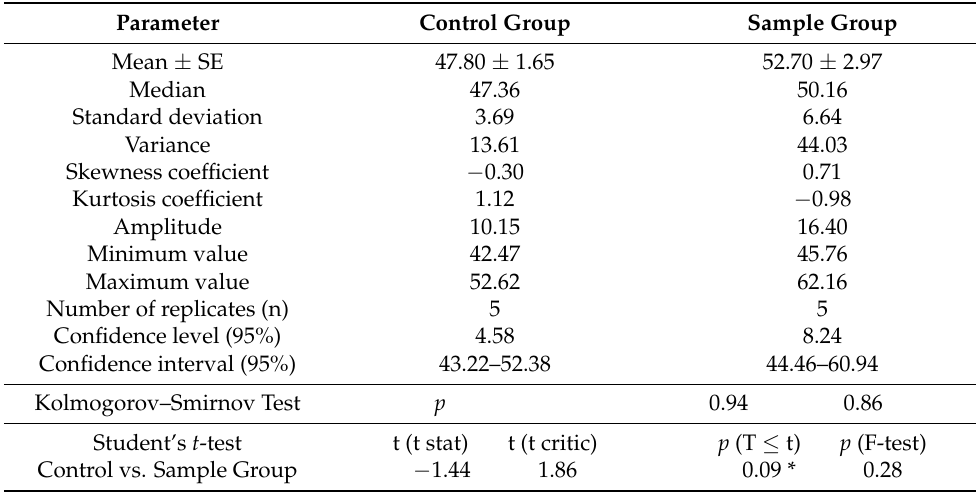
Table 4. The data processing of hematocrit (Hct) values.